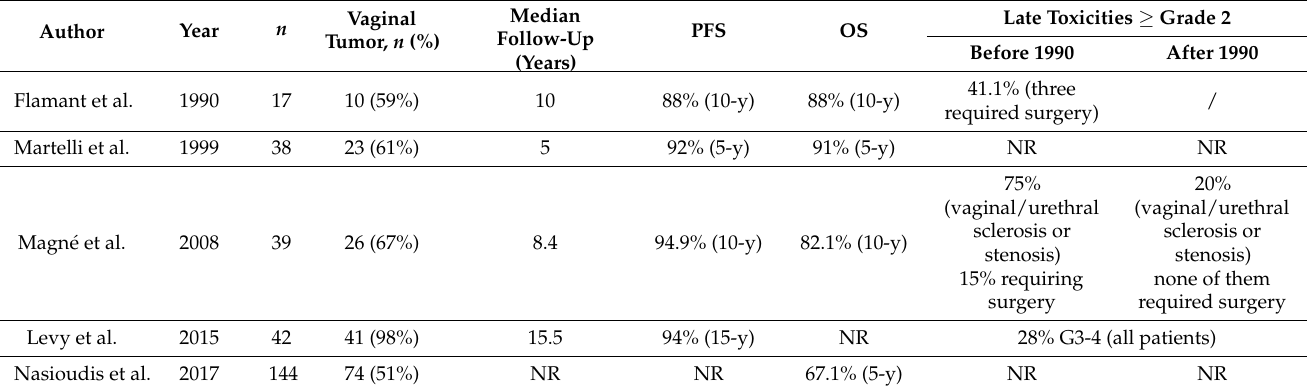
Table 4. Series of low-dose-rate BT for vaginal pediatric